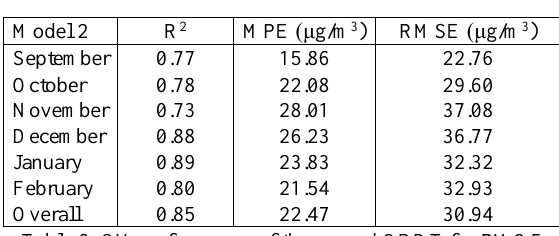
Table 3. CV performance of the second GBDT for PM2.5